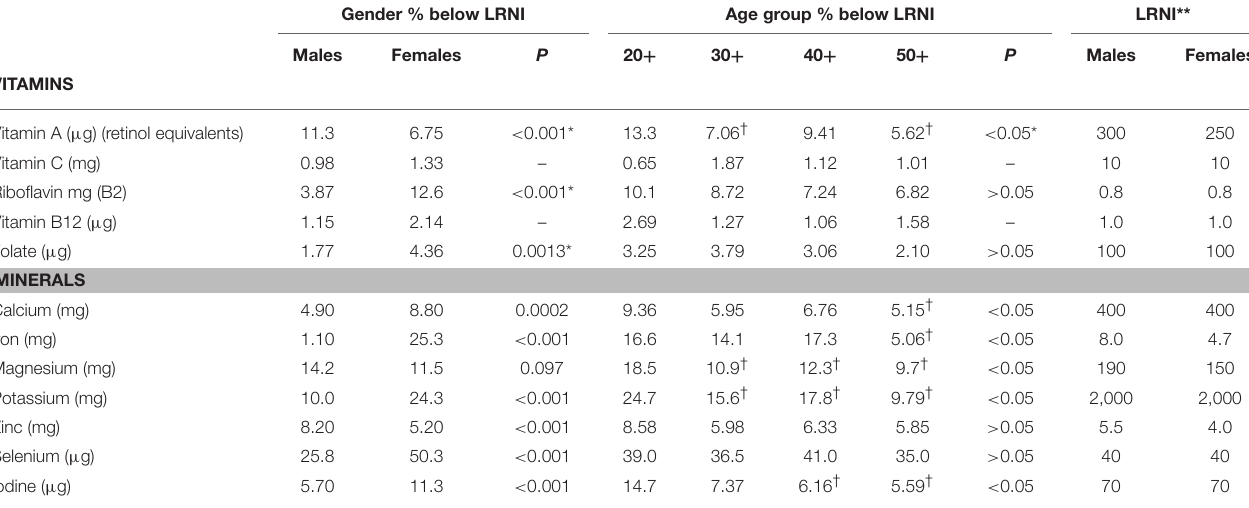
TABLE 3 | Percentage of adults below the LRNI for vitamin and mineral intakes by gender and age. Gender % below